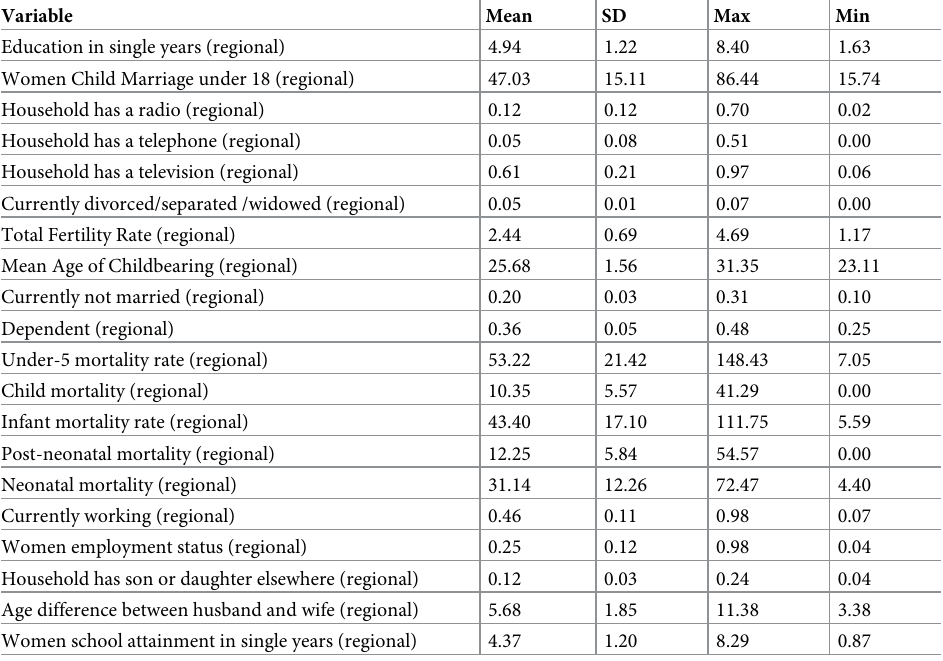
Table 2. Summary statistics of district level